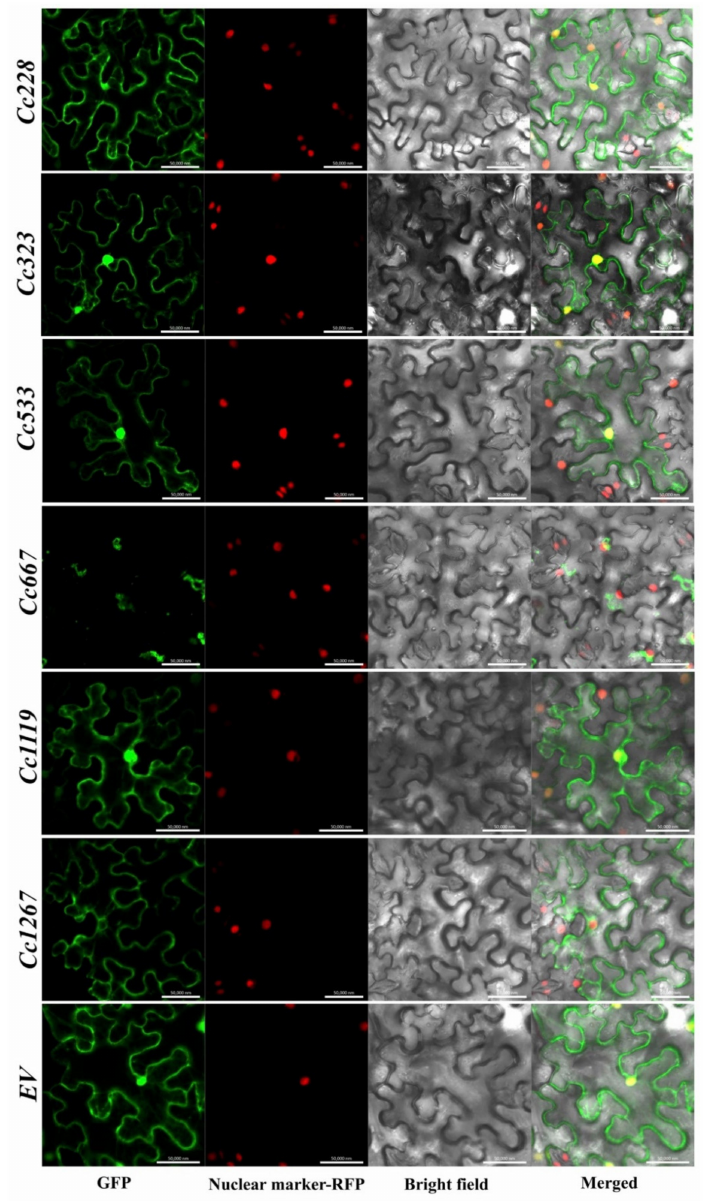
Figure 7. Subcellular localization of six CEPs based on confocal microscope. GFP: GFP-tagged CEPs were transiently expressed in N. benthamiana leaves; Nuclear marker-RFP: RFP-tagged nuclear of N. benthamiana epidermal cells; Bright field: this view shown the outline of the N. benthamiana epidermal cells; Merged: the view of samples under two excitation light. Bars = 50 µ m (EV: empty vector; CEPs: candidate e ff ectors proteins; GFP: green fluorescent protein; RFP: red fluorescent